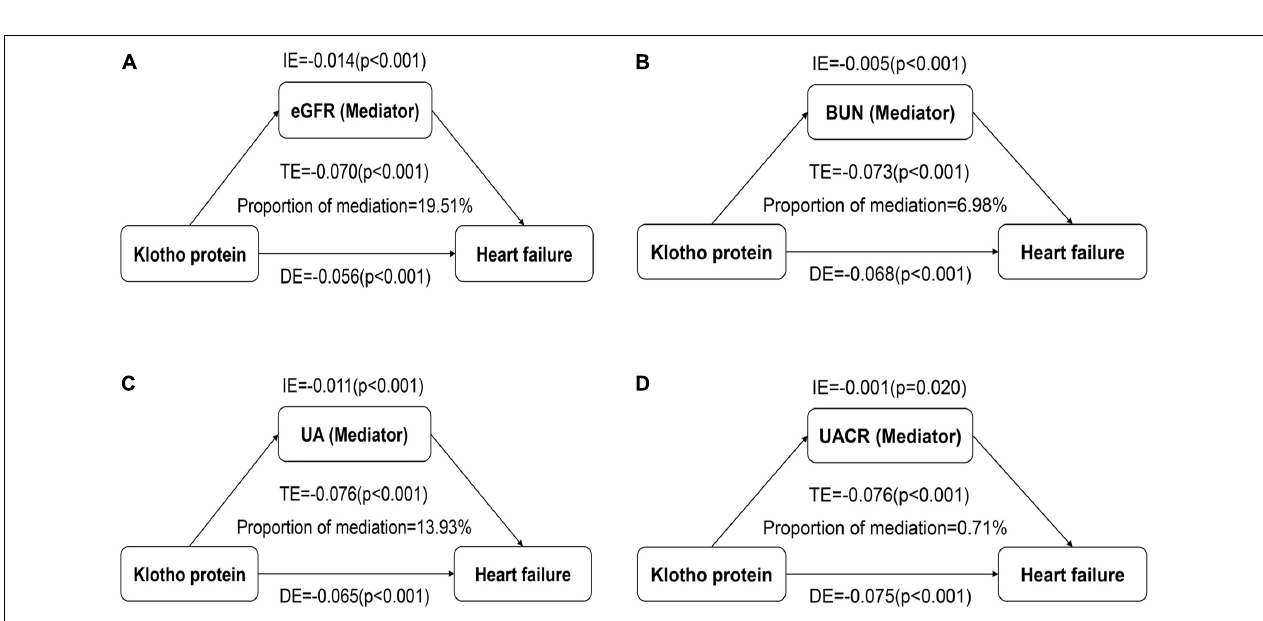
Frontiers in Cardiovascular Medicine |